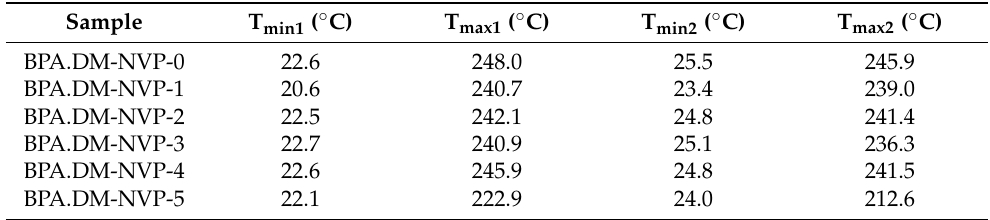
Figure 13. Temperature (T 1 ) along the free burning sample 1 (BPA.DM-NVP-0).